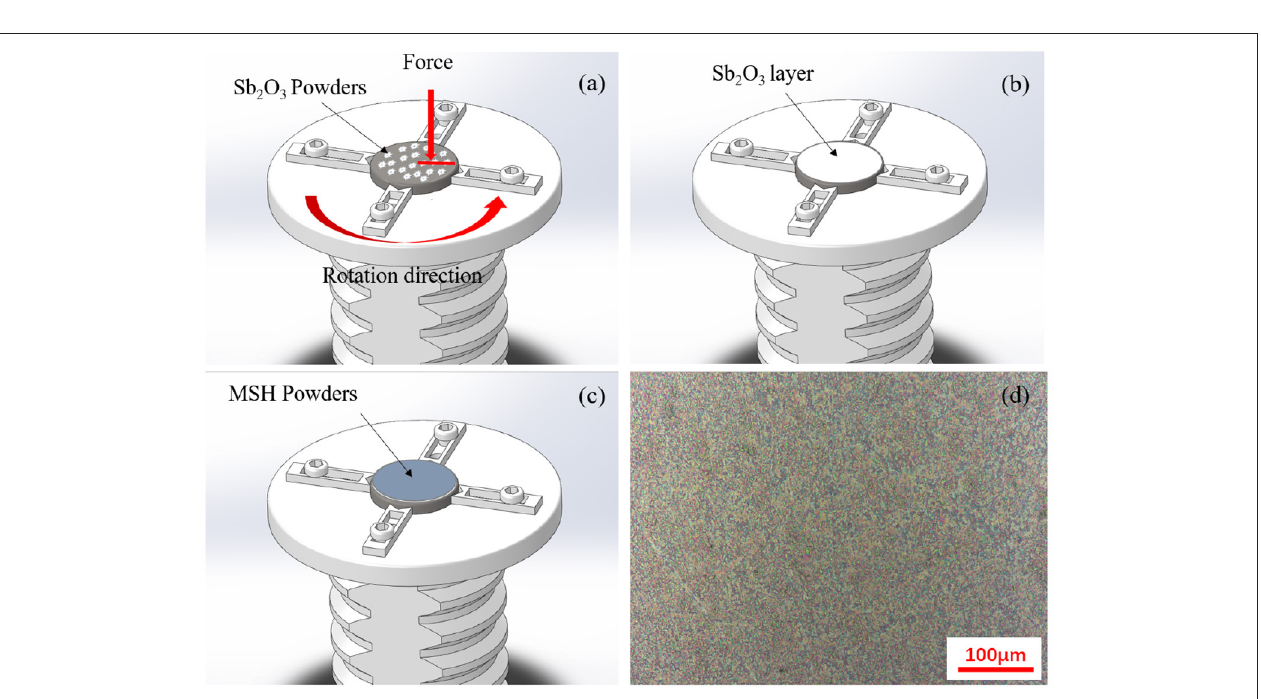
films was performed with Renishaw confocal Raman system (green laser) equipment with a home-built high temperature extension probe connected to the fiber optics attachment (the